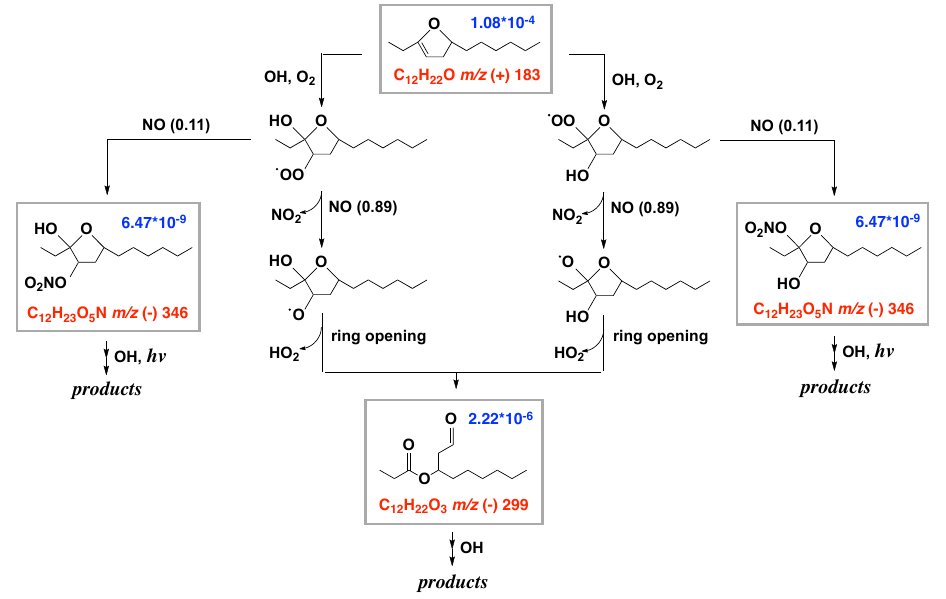
Fig. 2a. Proposed mechanism for the OH-initiated oxidation of alkyl-substituted dihydrofuran under high-NO x conditions. The boxes indicate compounds or reaction pathways incorporated in the model simulation. CIMS monitored species have m/z noted in red. Estimated vapor pressure (atm) of each compound is indicated in blue.